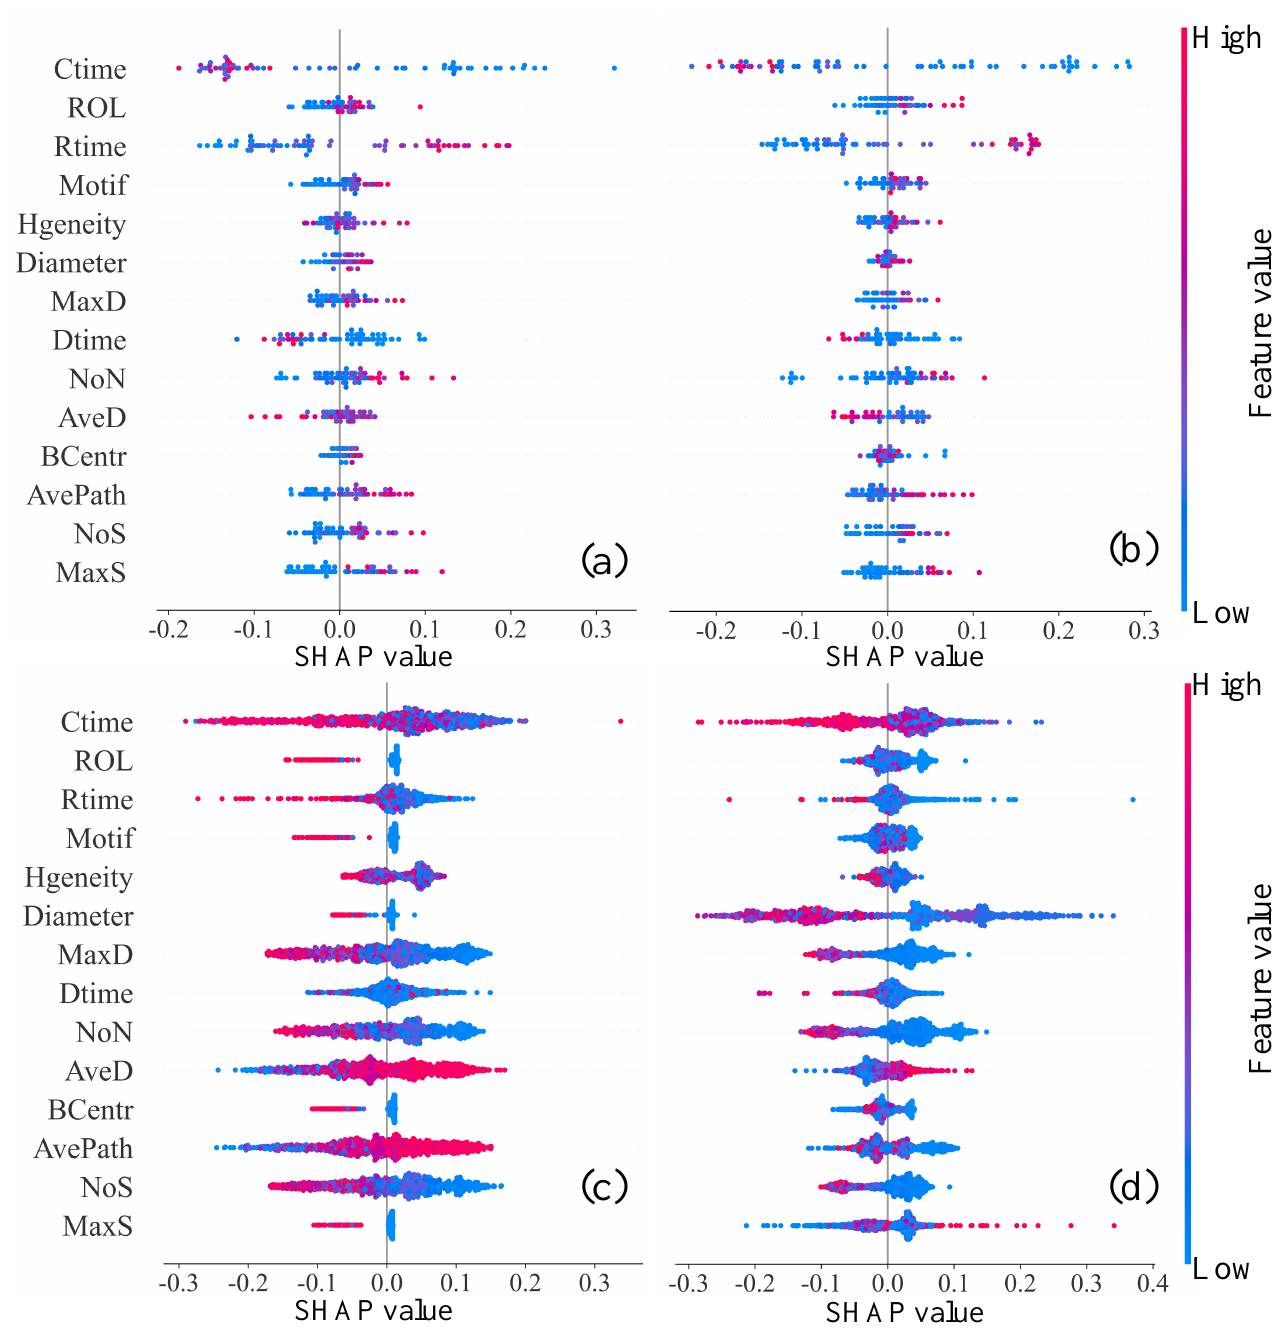
Figure 2. SHAP summary plots for the Twitter and Gossipcop datasets. ( a , b ) refer to the Twitter dataset, ( c , d ) refer to the Gossipcop dataset. The cut-off times are ( a , c ) 2.4 h and ( b , d ) 12